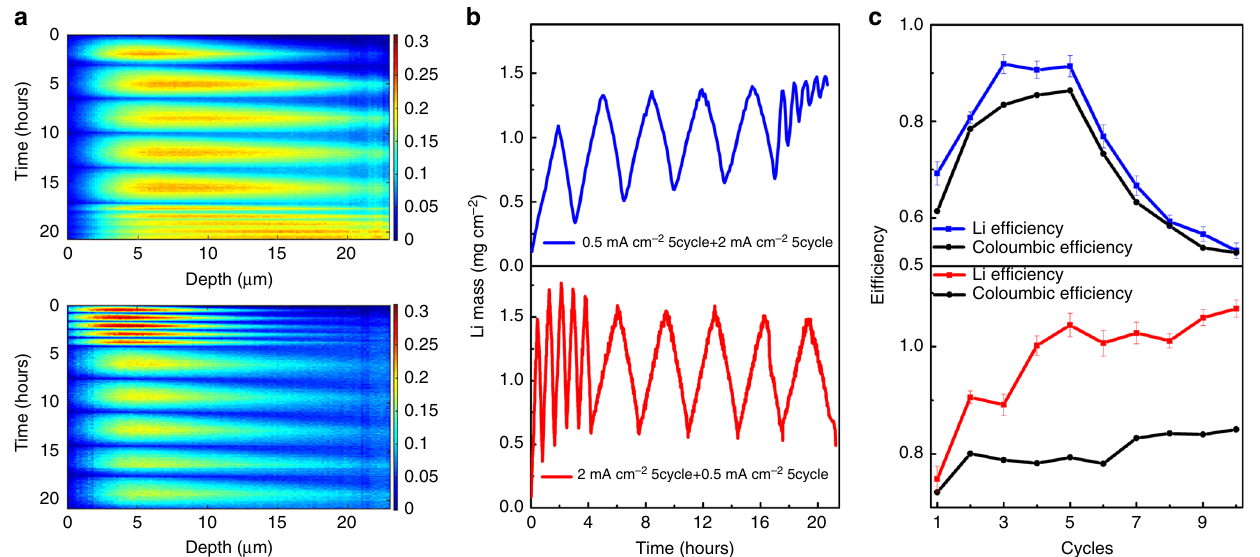
Fig. 5 Evolution of the total amount of Li. a Operando NDP for fi ve plating/stripping cycles at 2 mA cm – 2 followed by fi ve cycles at 0.5 mA cm − 2 and for fi ve plating/stripping cycles at 0.5 mA cm − 2 followed by two cycles at 0.5 mA cm − 2 all up to 1 mAh cm − 2 plating capacity. The depth is measured starting from the interface of the Cu current collector with the electrolyte/SEI/Li-metal. b Integrated amount of Li from the operando NDP experiments in a . c Coulombic ef fi ciency and Li ef fi ciency during the cycling